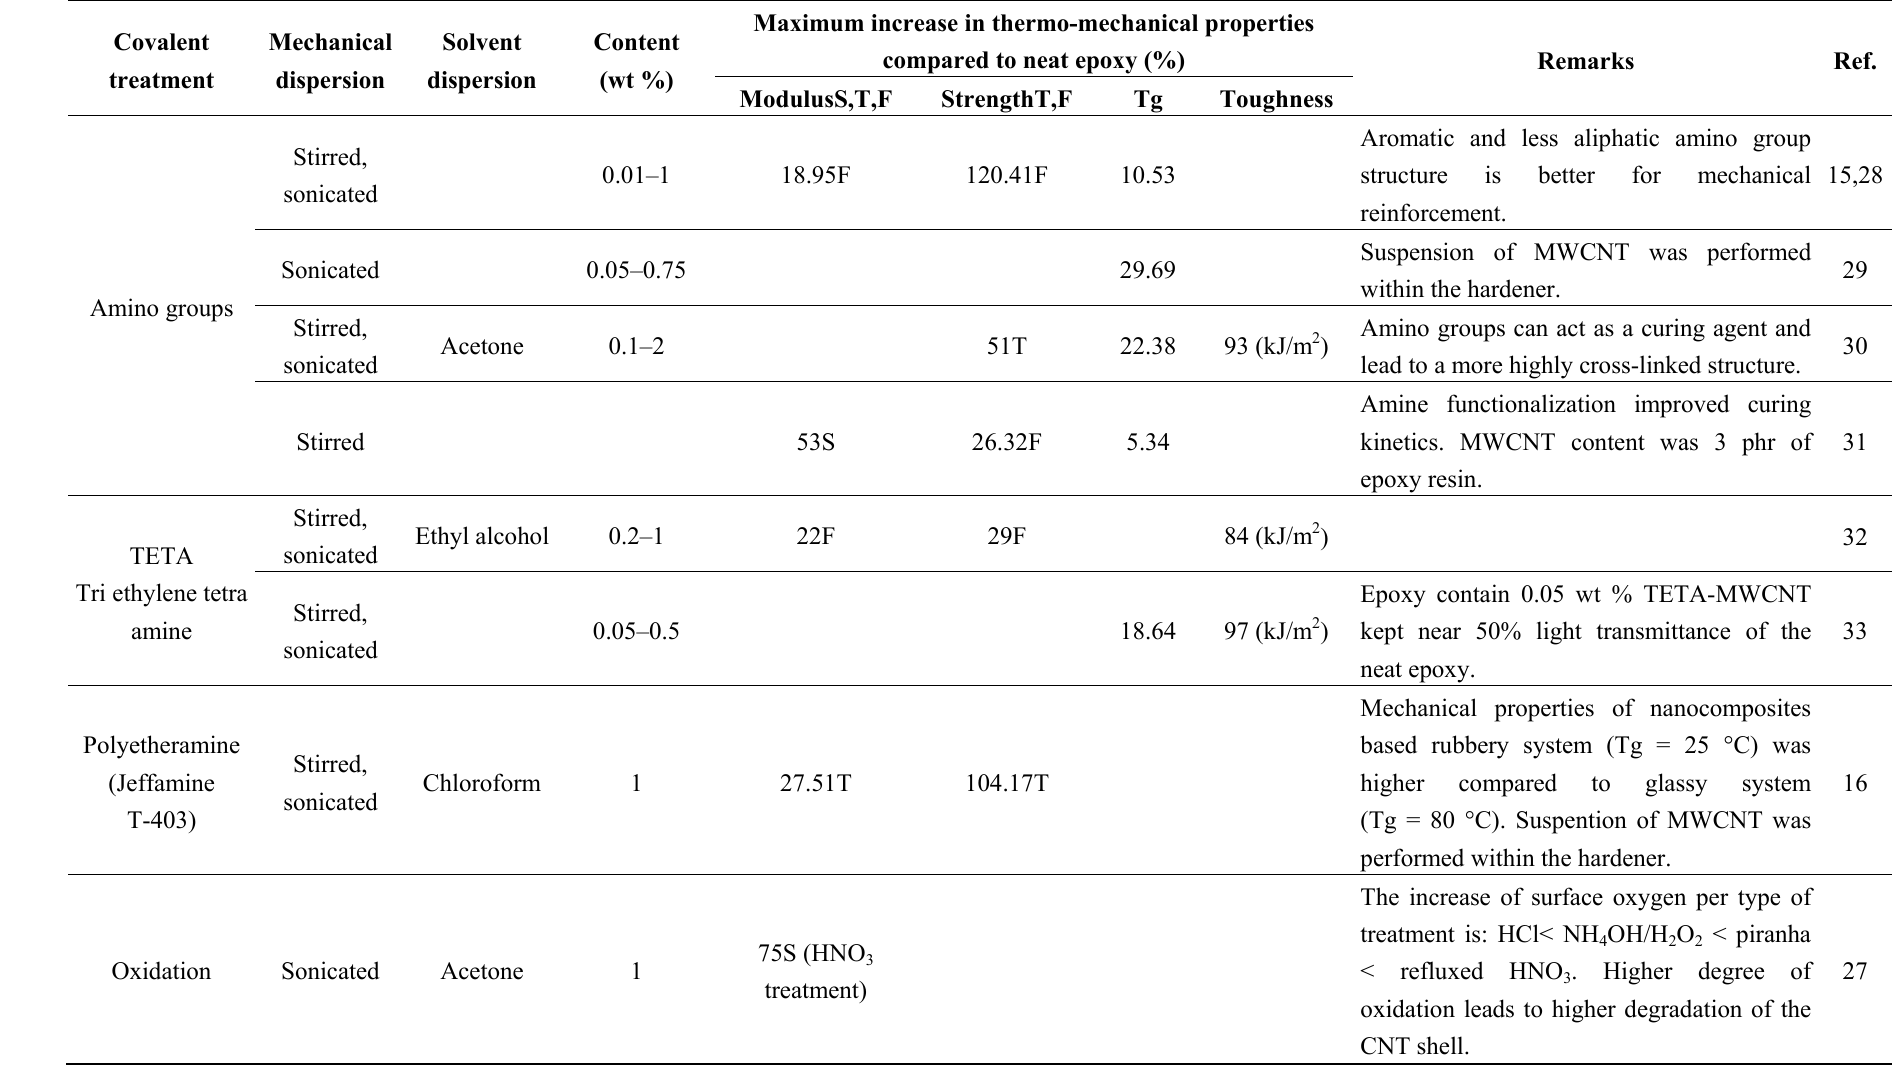
Table 1. Effect of covalent treatment of MWCNT on the thermo-mechanical properties of epoxy